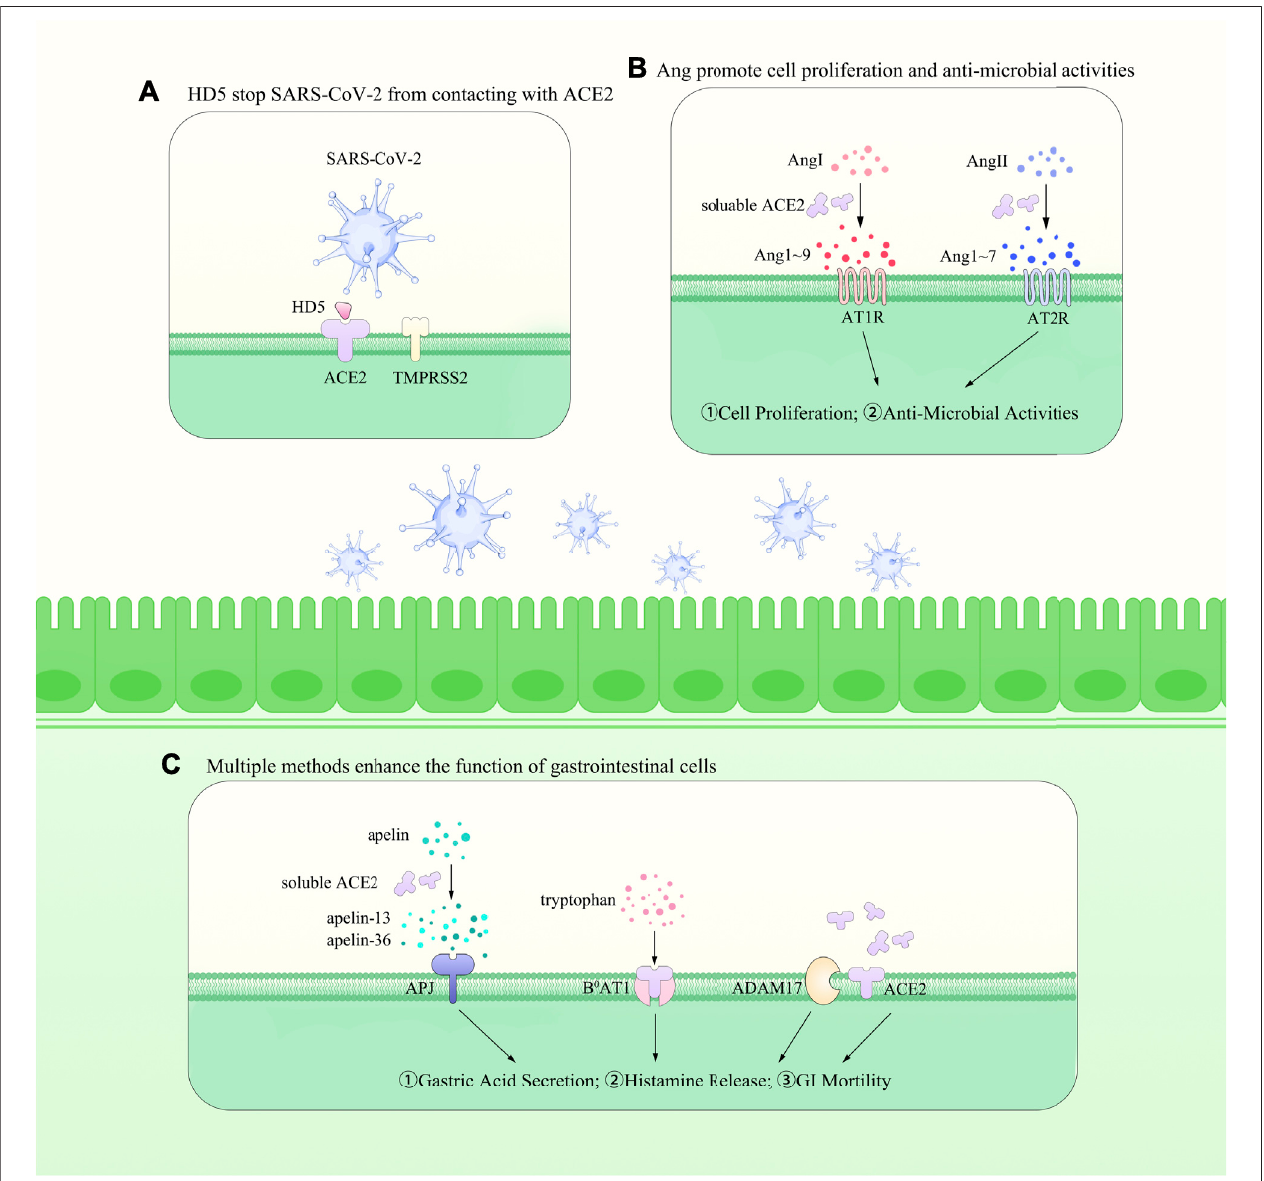
FIGURE1 | The rolesof ACE2 withinthe gut. In the meantime, itpromotes the SARS-CoV-2 entry intothe epithelial cells with the association ofTMPRSS2[shown in (A) ].Besides,as an important regulator ofRAS, itcleaves Ang Ito Ang-(1 – 9) and Ang II toAng-(1 – 7) and helps with themaintenance ofblood pressure [shown in (B) ]. ACE2 is widely expressed on the membrane of gastrointestinal epithelial cells and could be cleaved into soluble ACE2 via ADAM17. In the meantime, it mediates the transportation of amino acids and is responsible for the apelin peptides [shown in (C) ]. However, it also promotes the SARS-CoV-2 entry into the host cells, increasing the dif fi culty in understanding its exact effects within the GIT and in the whole